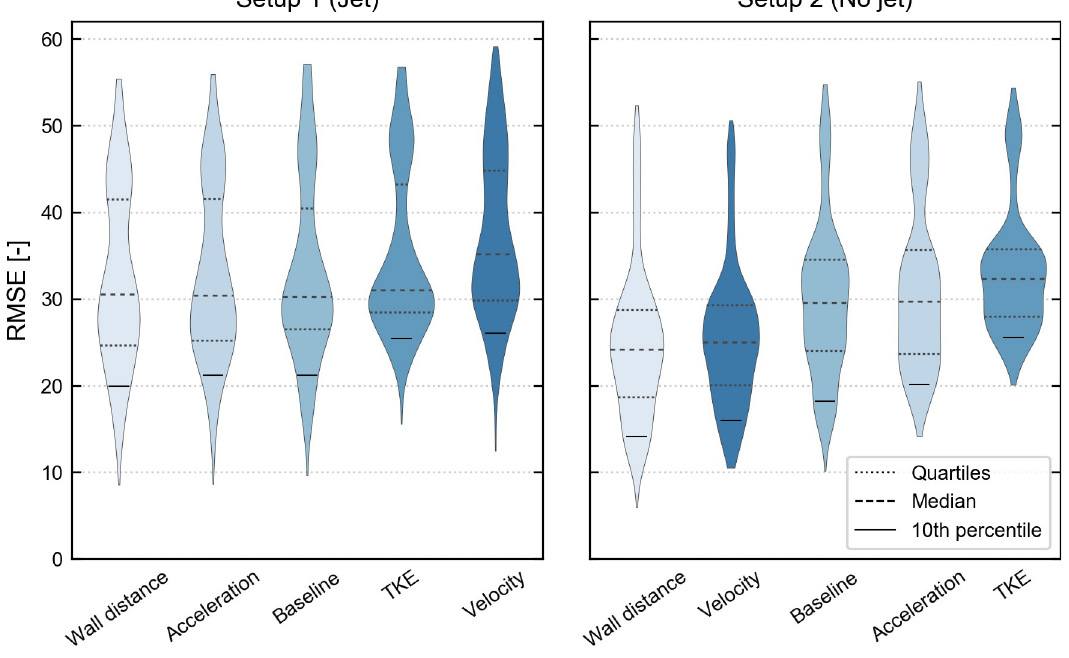
Fig 5. Violin plots indicating the frequency of root-mean-square error values (RMSE) in both setups. Ordering the stimulus versions by increasing 10 th percentile reveals similarities and significant differences. Results are better if RMSE is closer to zero. The lower violin tip indicates the result of the best parameter set(s) for each stimulus version. Underlying data in S6